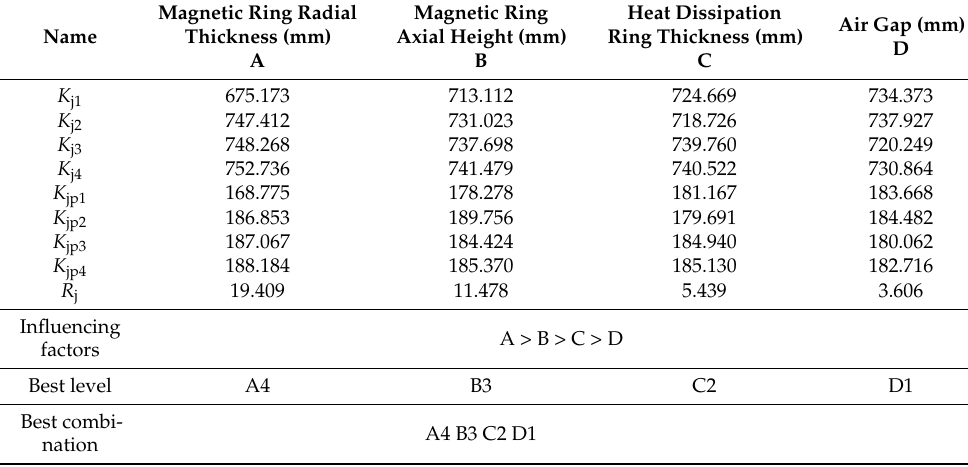
Table 3. Orthogonal analysis.